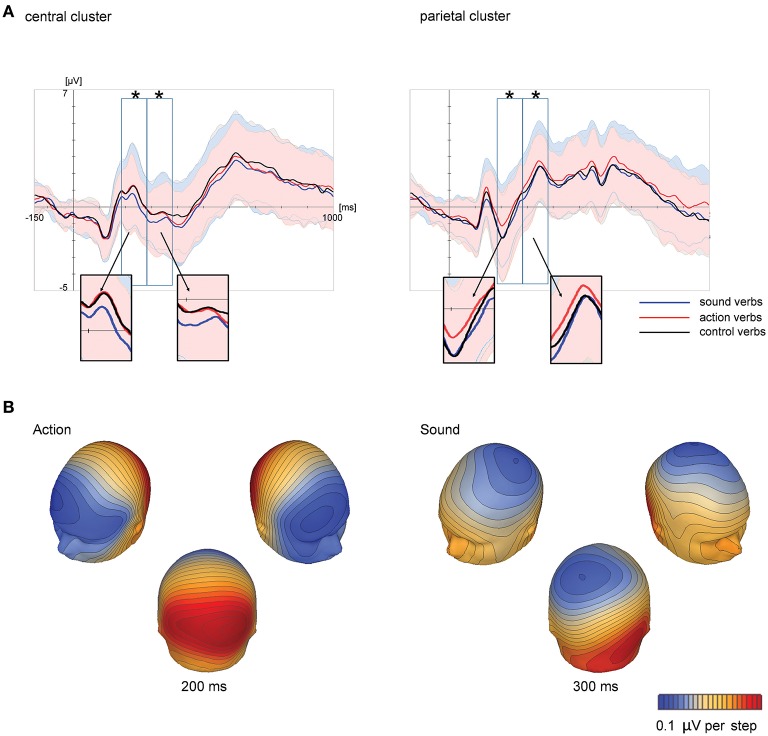
Grand-averaged ERPs at central and parietal scalp regions, averaged across electrode sites within each scalp region, in Experiment 1 (A) as a function of feature type (action, sound, and control verbs). Time windows analyzed statistically (180–280, 280–380, and 380–480 ms) are marked by black rectangles. Colored shadings indicate standard deviations. Significant ERP effects of feature type are highlighted by asterisks. Corresponding topographical potential maps at the time point of maximum global field power are shown (B) for ERP differences between action and control verbs as well as been sound and control verbs.